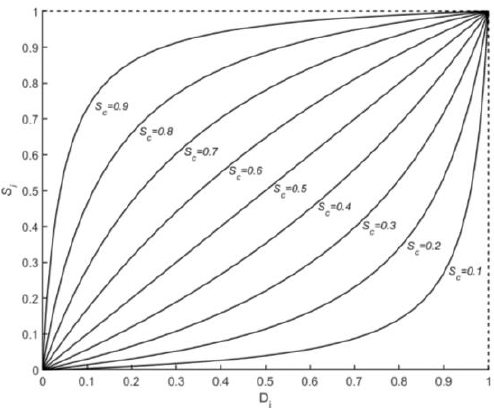
Figure 2. The water distribution curves for typical water saturation coefficient S c.